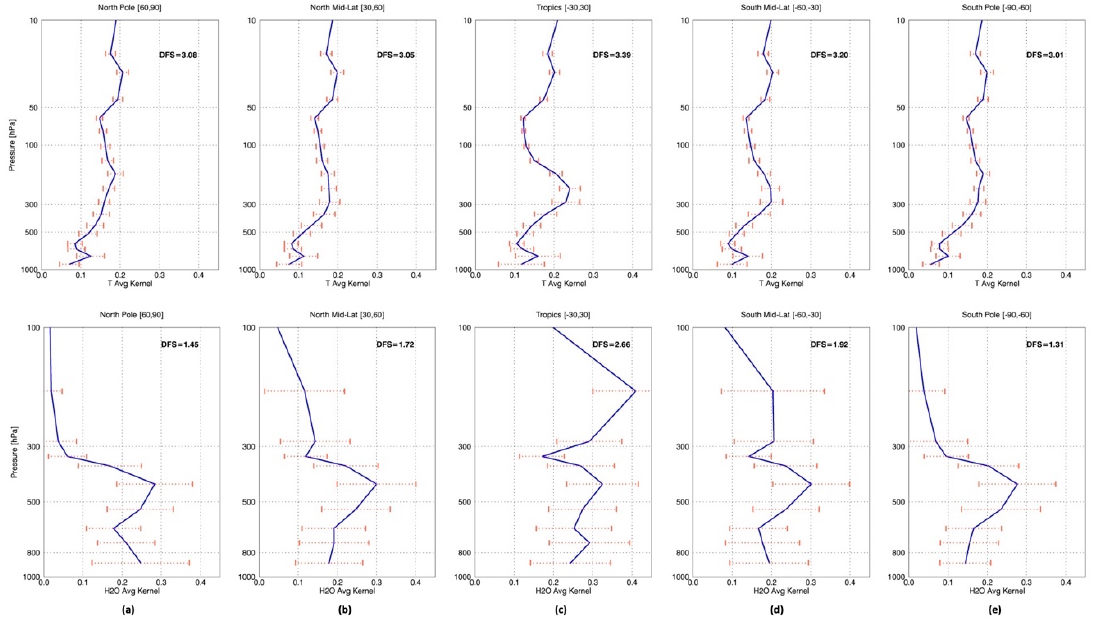
Figure 4. CLIMCAPS averaging kernels ( A ) for temperature (top row) and moisture (bottom row) retrievals from an ascending SNPP orbit (daytime) on 21 March 2018. CLIMCAPS generates profiles of A for each retrieval individually to characterize the amount of information contributed by the measurement at each retrieval level. Here they are averaged (blue) across latitudinal zones with error bars (orange) characterizing its variance at each pressure level. The zones are ( a ) North Pole, ( b ) Northern mid-latitude, ( c ) Tropics, ( d ) Southern Mid-latitude and ( e ) South Pole. The zonal average degrees of freedom (DFS) is listed at the top in each figure. The error bars represent the standard deviation of A ( l , l ) values at each pressure level P ( l , l ) across the latitudinal zone.